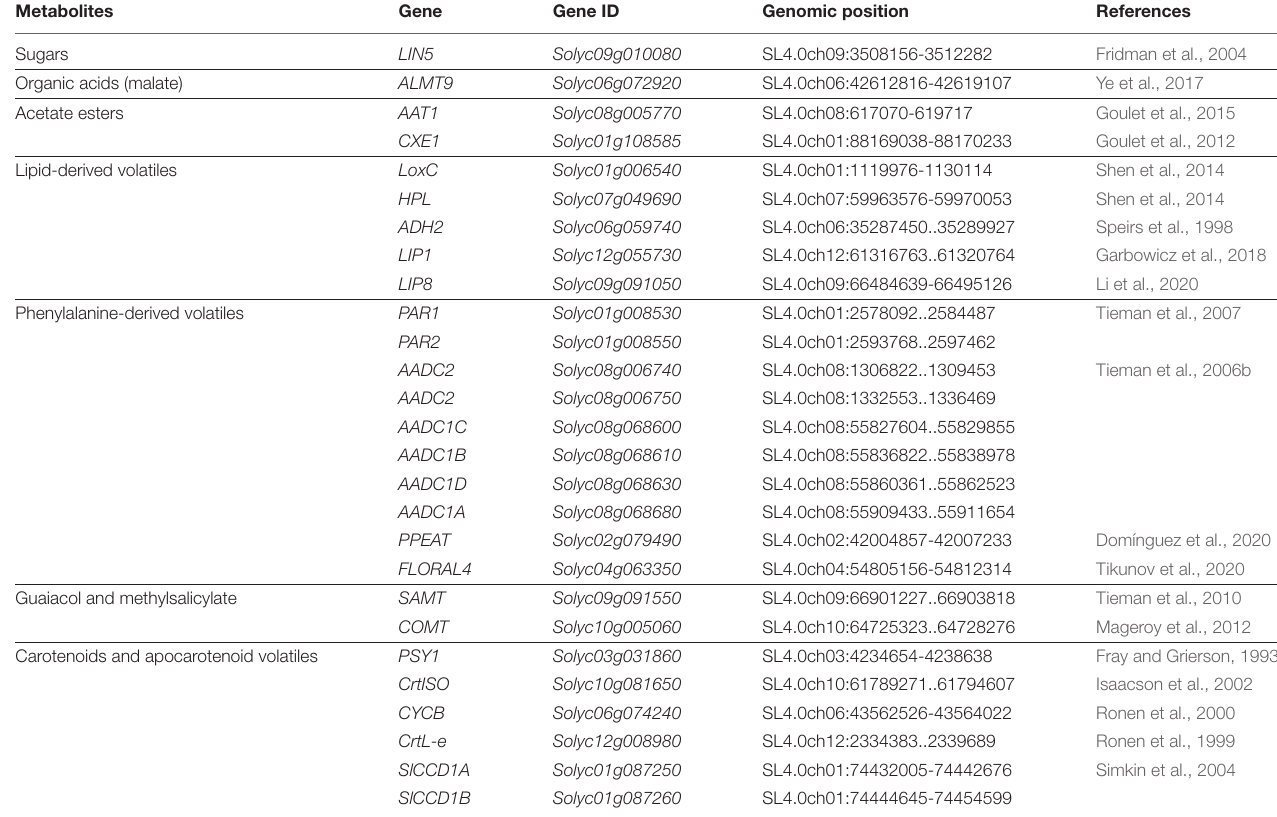
TABLE 1 | Compilation of known flavor-related genes in